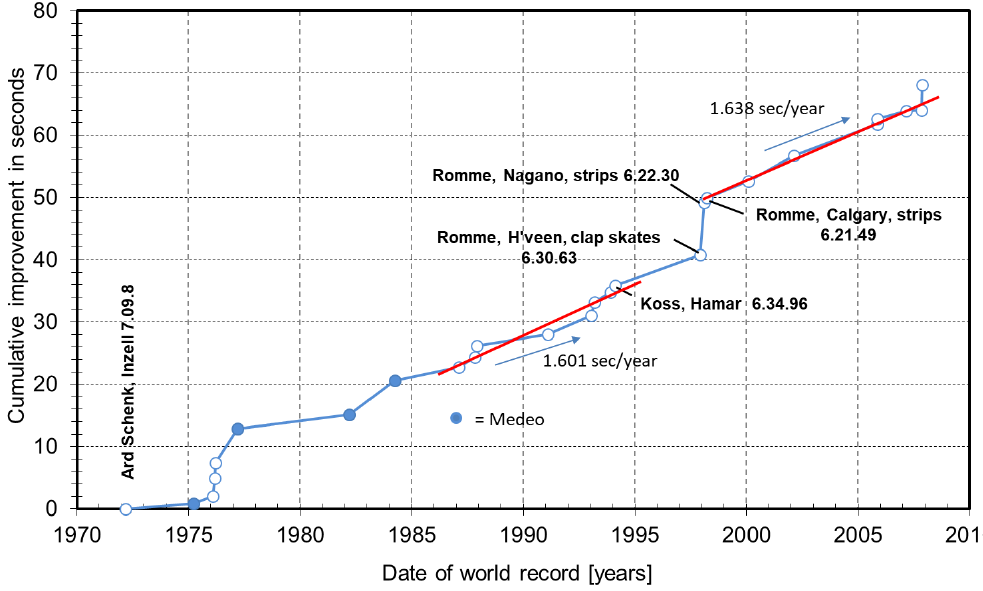
Figure 11. Cumulative improvement of the 5000 m world record since 1972.